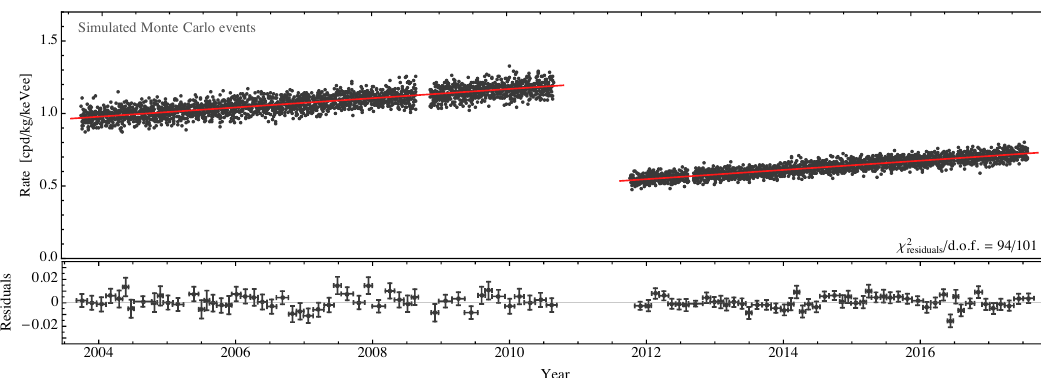
Figure 2 . Upper: Monte Carlo events generated assuming no modulation, a slow linear growth in time, B = (0 : 01 (cid:25)= yr) cpd = kg = keVee, and the same cumulative rate as DAMA/LIBRA Phase 1 and 2. Lower: residuals computed with respect to the smooth average are compatible with no